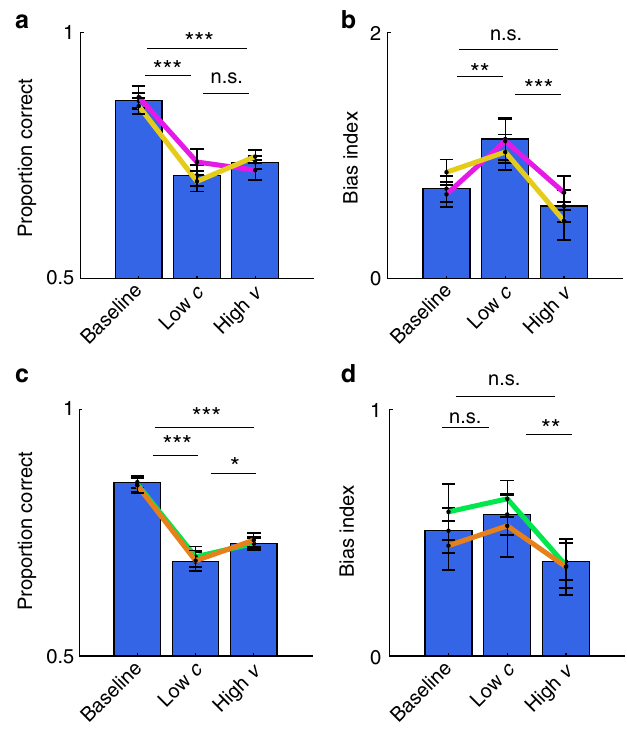
Fig. 6 Experimental evidence against variability mixing. a Choice accuracy for the baseline, reduced contrast (low- c ), and increased variability (high- v ) conditions for Experiment 4. b In Experiment 4, the in fl uence of the prior cue is highest when encoding noise is high (low- c ) and lowest when integration noise is high (high- v ). c Same as panel a , but for Experiment 5. d Same as panel b , but for Experiment 5. a , b Coloured lines indicate trials where the categorisation of contrast was correct (pink) and where the categorisation of variability was correct (yellow). c , d Coloured lines indicate trials where the contrast level was blocked (green) or when the variability level was blocked (brown). We note that the difference in bias index for the low- c condition between contrast blocking and variability blocking can be explained by a general shift in the bias index according to block dif fi culty: when contrast is blocked, the low- c condition is accompanied by the hardest condition (the condition with low contrast and high variability), but when variability is blocked, the low- c condition is accompanied by the easiest condition (the condition with high contrast and zero variability). a – d Data are represented as group mean ± SEM. For